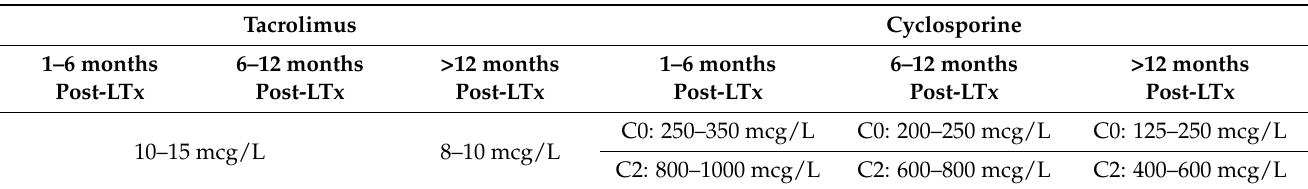
Table A1. Target trough blood levels for calcineurin inhibitors in lung